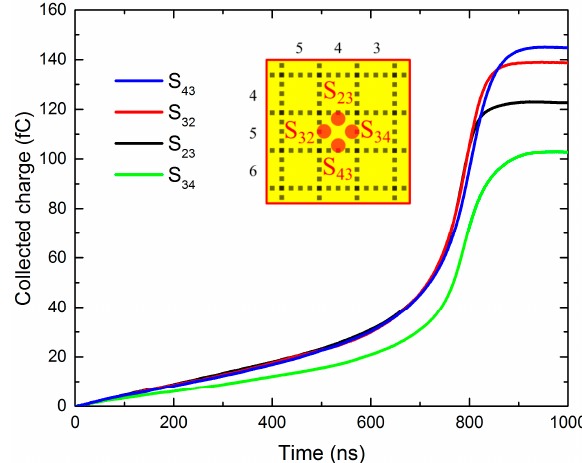
Figure 14. Temporal evolution of the charge collection in the spots distributed symmetrically around CP.